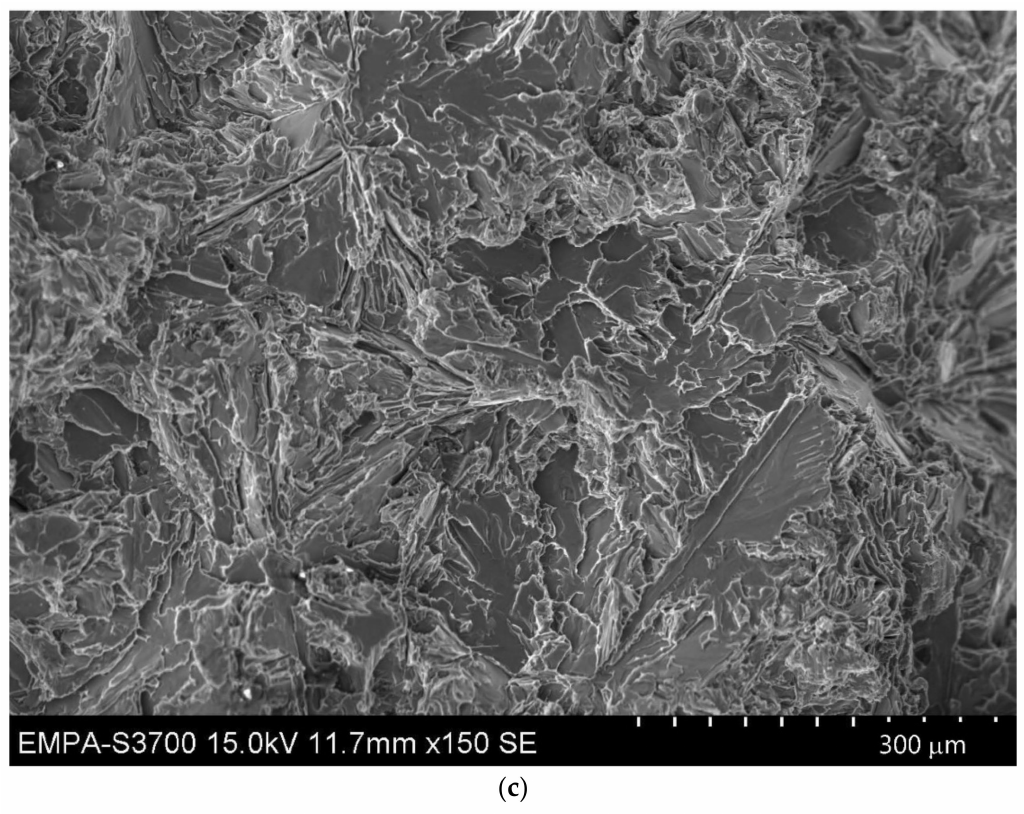
Figure 3. Fracture surface: ( a ) macroscopic optical view, ( b ) area covered by corrosion products (red), and ( c ) microscopic optical view of the non-corroded brittle fracture surface (area marked in